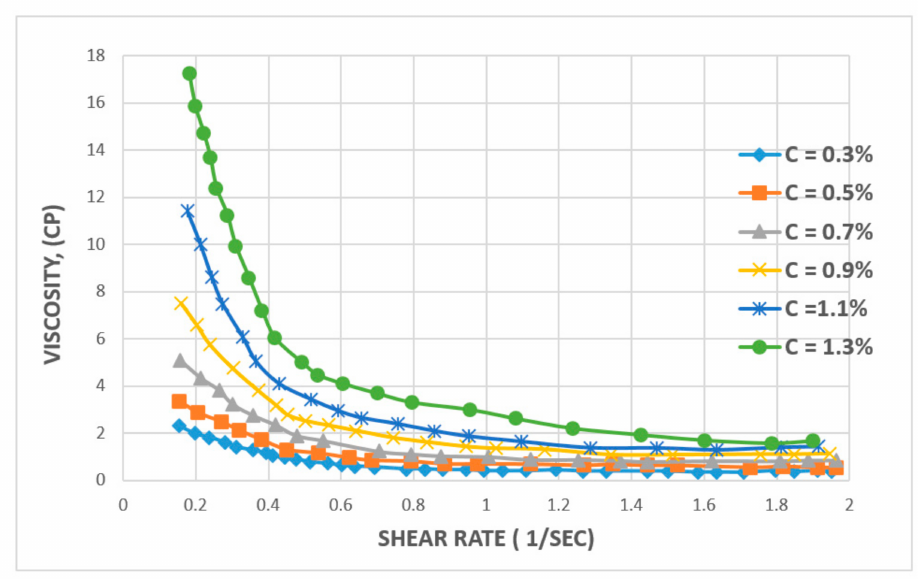
Figure 12. E ff ect of shear rate on the viscosity of XG solution at various concentrations. Reprinted and modified from